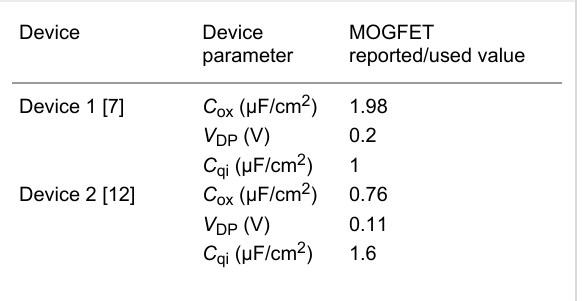
Table 1: Device parameters for devices 1 and